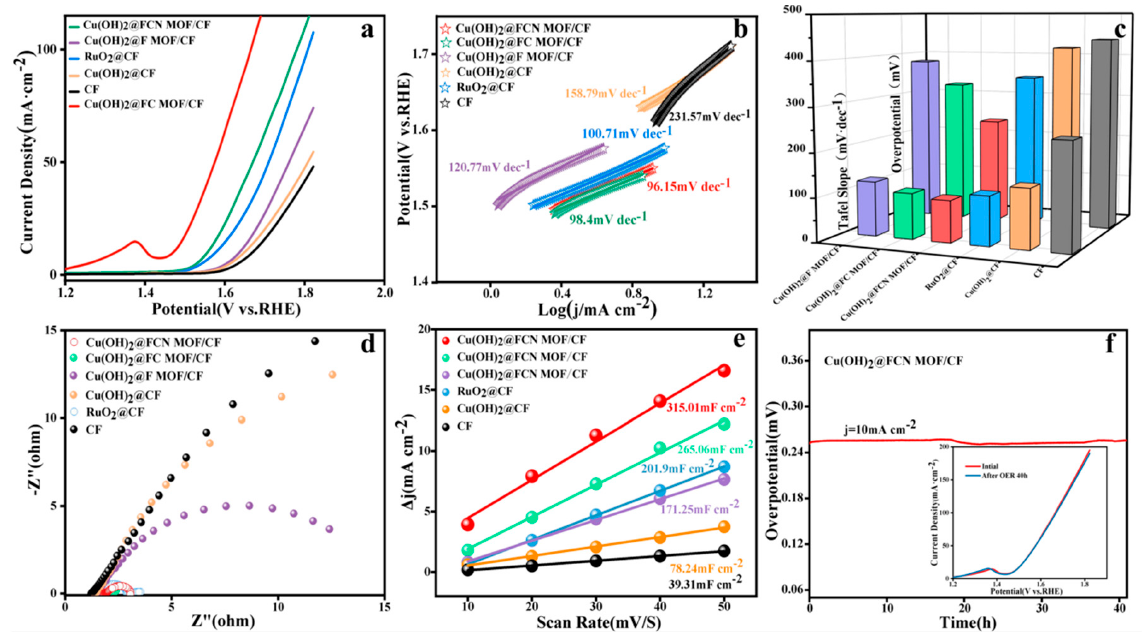
Figure 3. OER electrocatalytic performance. ( a ) LSV curves and ( b ) Corresponding Tafel plots of Cu(OH) 2 @FCN MOF/CF, Cu(OH) 2 @FC MOF/CF, Cu(OH) 2 @F MOF/CF, Cu(OH) 2 @CF, CF and RuO 2 @CF. ( c ) Overpotential and Tafel plots of Cu(OH) 2 @FCN MOF/CF, Cu(OH) 2 @FC CMOF/CF, Cu(OH) 2 @F MOF/CF, Cu(OH) 2 @CF, CF and RuO 2 @CF. ( d ) Nyquist plots of Cu(OH) 2 @FCN MOF/CF, Cu(OH) 2 @FC MOF/CF, Cu(OH) 2 @F MOF/CF, Cu(OH) 2 @CF, CF and RuO 2 @CF. ( e ) Double-layer capacitance plots. ( f ) Current density curves over time at 10 mA·cm − 2 (inset is the polarization curves before and after 40 h OER).